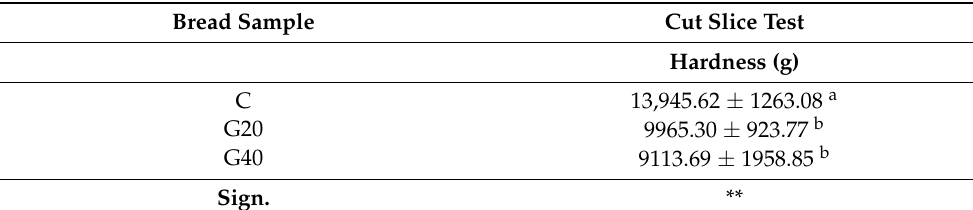
Table 2. Rheological properties of goji enriched bread.